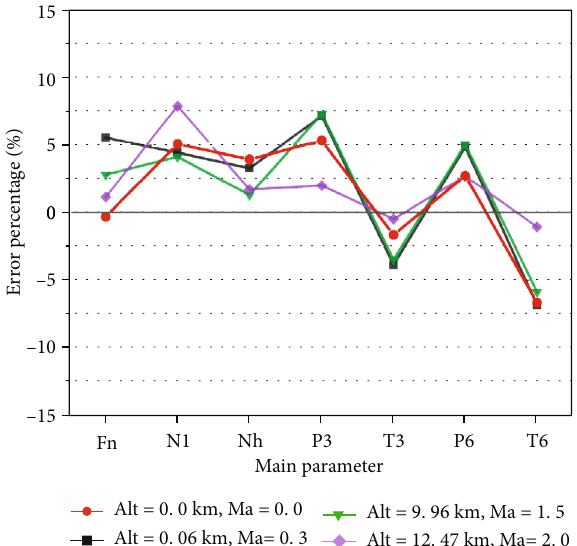
Figure 12: Error analysis diagram of model numerical calculation results and experimental reference